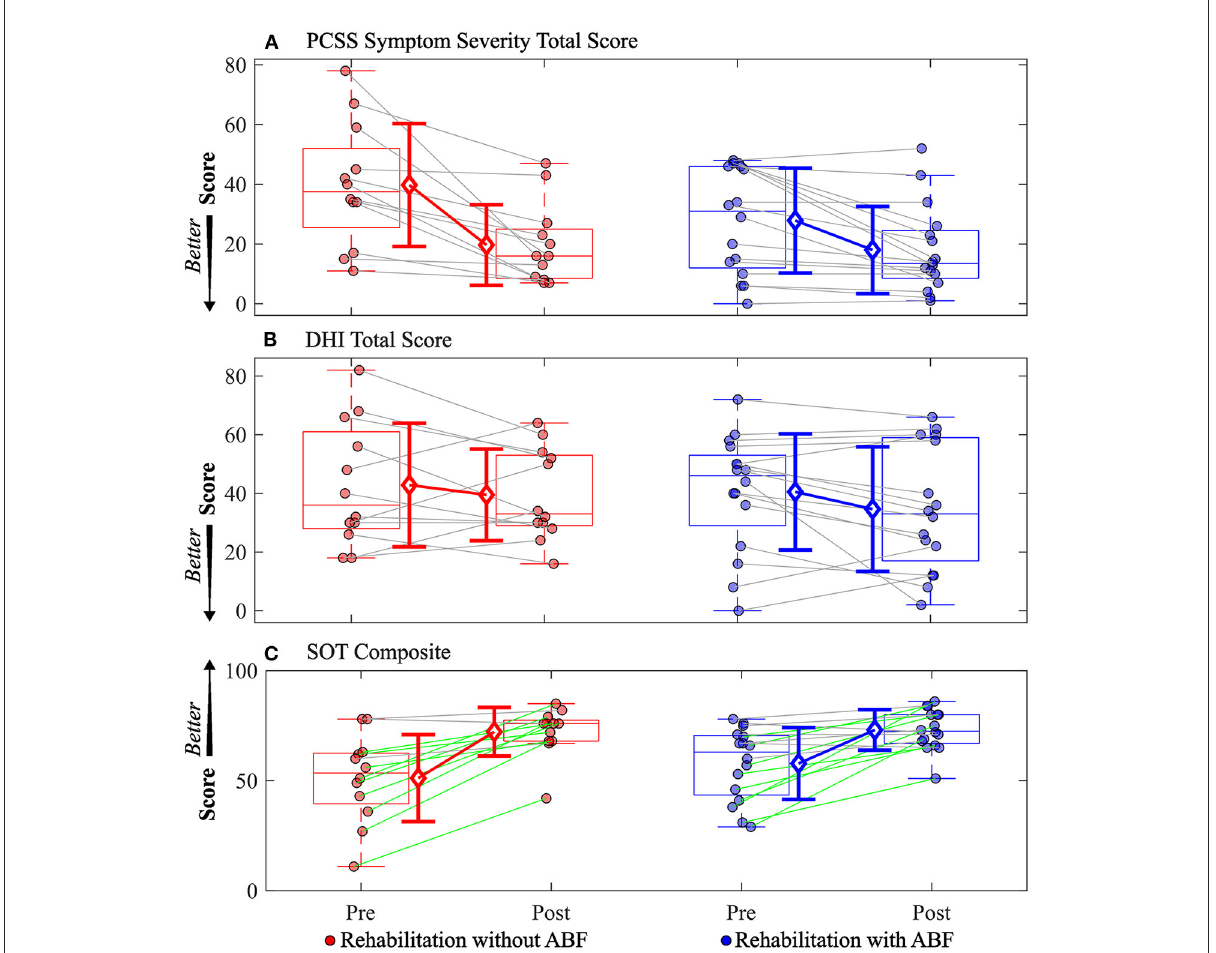
FIGURE1 Individual participant data pre- and post-rehabilitation for groups without audio biofeedback (ABF—red) and with ABF (blue) for (A) Post-concussion Symptom Scale (PCSS) Symptom Severity total score, (B) Dizziness Handicap Index (DHI) total score, and (C) Sensory Organization Test (SOT) composite score. Central box shows median (center line) with upper and lower quartiles defined by 0.75 quantile and 0.25 quantile values, respectively. Whiskers extend to maximum and minimum values that are not considered outliers. Mean values are indicated by open diamonds with + /- 1 standard deviations. For the SOT composite score, green lines connecting participants indicate increased composite scores that were greater than the minimal detectable change of 8 as defined by a previous study (35); gray lines indicate composite scores were within the minimal detectable change range of + /- 8. Otherwise gray lines connect individual participant